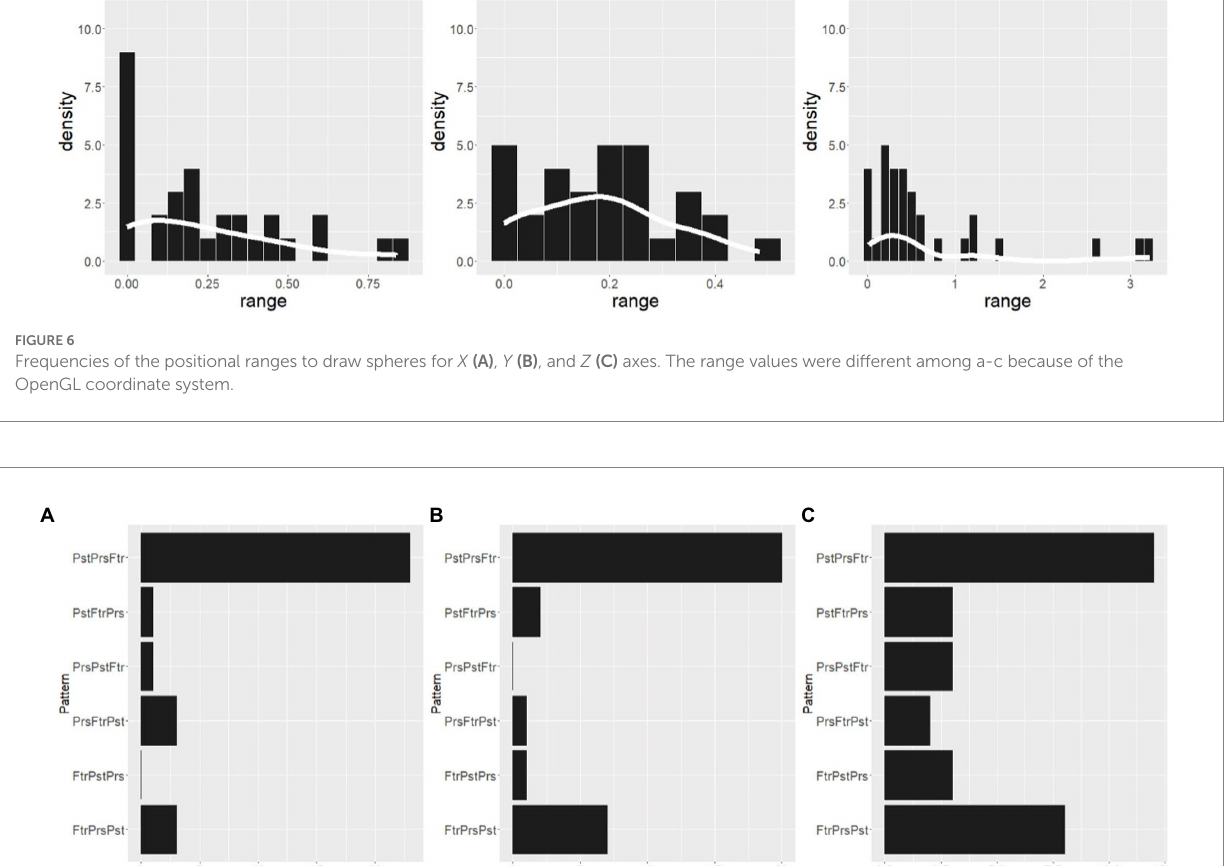
FIGURE 7 Frequencies at which participants drew the spheres from left to right (A) , from bottom to top (B) , or from the furthest to the nearest (C) in Past- Present-Future (“PstPrsFtr” in the figure), Past-Future-Present (“PstFtrPrs” in the figure), Present-Past-Future (“PrsPstFtr” in the figure), Present-Future- Past (“PrsFtrPst” in the figure), Future-Past-Present (“FtrPstPrs” in the figure), and Future-Present-Past (“FtrPrsPst” in the figure)